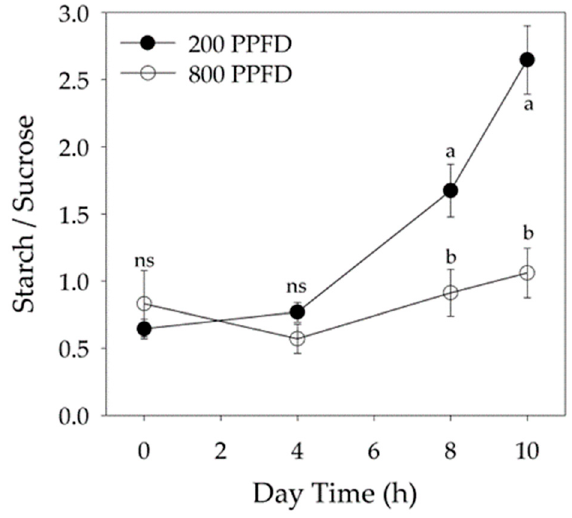
Figure 4. Starch to sucrose ratio during the light period in leaves of plants grown under 800 μ mol m − 2 s − 1 (800 PPFD) and 200 µ mol m − 2 s − 1 (200 PPFD). Mean values ± S.E. (n = 12). Different letters indicate significant differences at p = 0.05 (Fisher’s post-hoc test), ns—not significant. At the end of the light period, in leaves acclimated at low light, 68.5% of total carbohy- drates were partitioned towards the formation of starch reserves, while at high irradiance 43.6% of the sugars consisted of starch. The percentage of soluble carbohydrates was two times lower than that of starch in spinach leaves grown at 200 PPFD, while soluble carbohydrates were higher than starch at 800 PPFD (Table